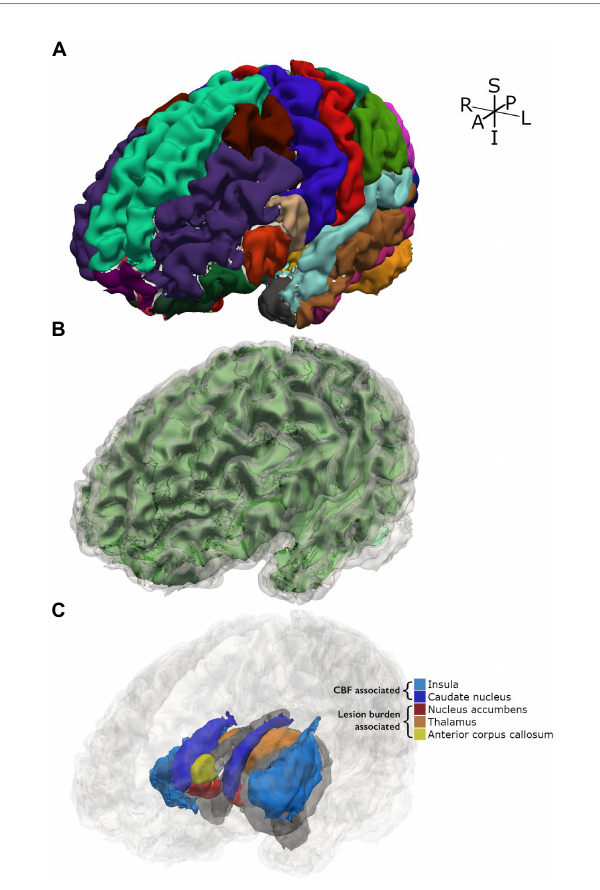
FIGURE 4 3D parcellation of a representative participant with SCD. (A) Shows FreeSurfer cortical parcellation. (B) Shows gray matter segmentation (translucent gray) over white matter segmentation (green). (C) Shows subcortical and cortical structures for which significant associations with tested independent variables were found. Other structures are displayed in gray as spatial